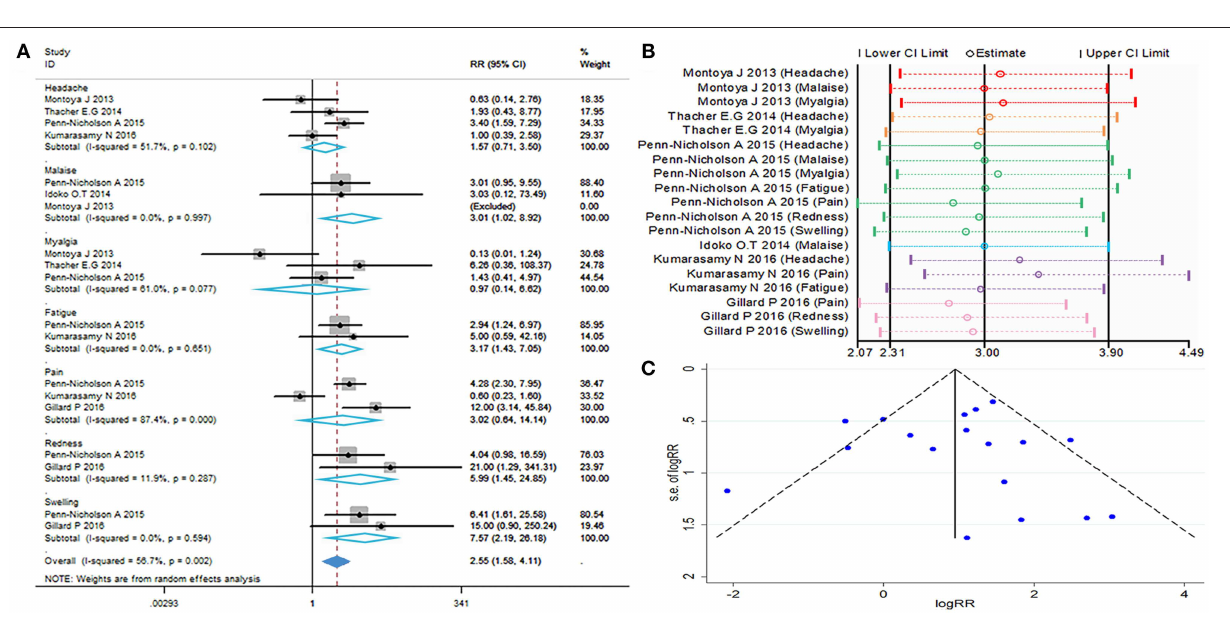
after vaccination in HIV-positive and